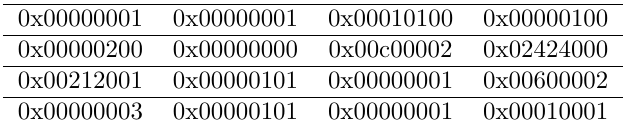
Table 7: Output bits of the linear characteristic with input s 9